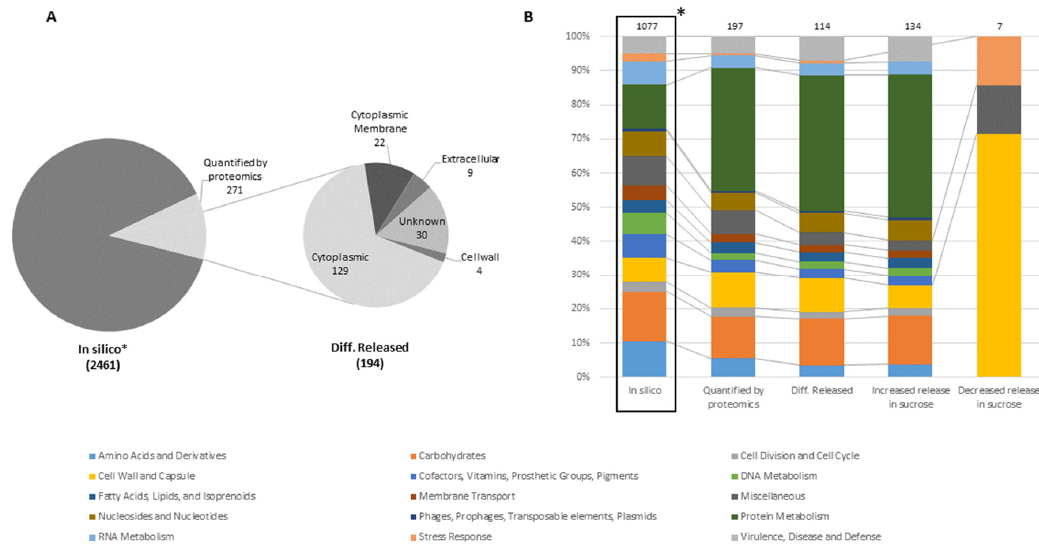
Figure 3. Analysis of the exoproteomes of glucose and sucrose-treated cells. ( A ) Comparison of the putative functional proteome (in silico) using the predicted subcellular localization of proteins, detected in the exoproteomes using proteomics; ( B ) Comparison of the SEED category distributions of the putative functional proteome (in silico), the quantified exoproteomes detected by proteomics (detected in four out of five replicates of at least one group), the differentially released proteins and proteins that were significantly more or less released in the presence of sucrose. The SEED subsystem proteome coverage was around 44%. (*) Derived from Di Xu et al. [36] .